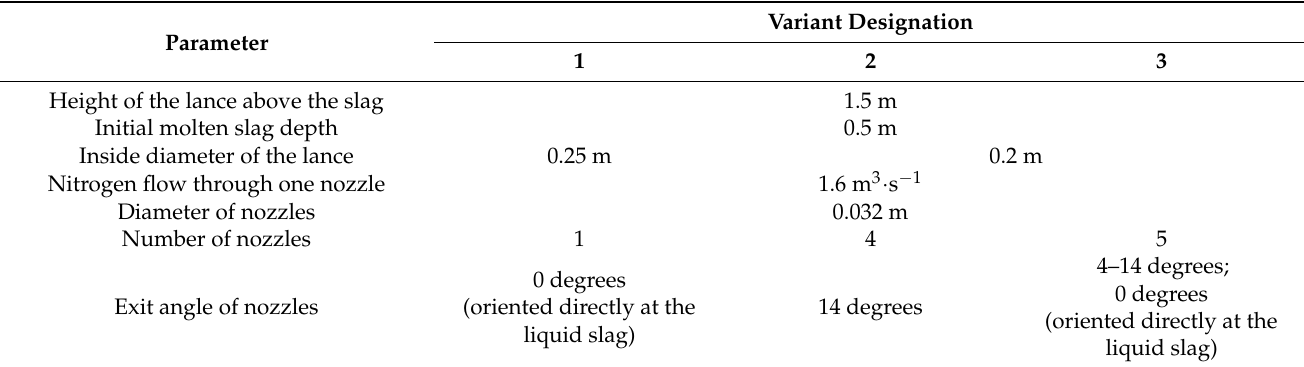
Table 1. Parameters adopted for CFD calculations.